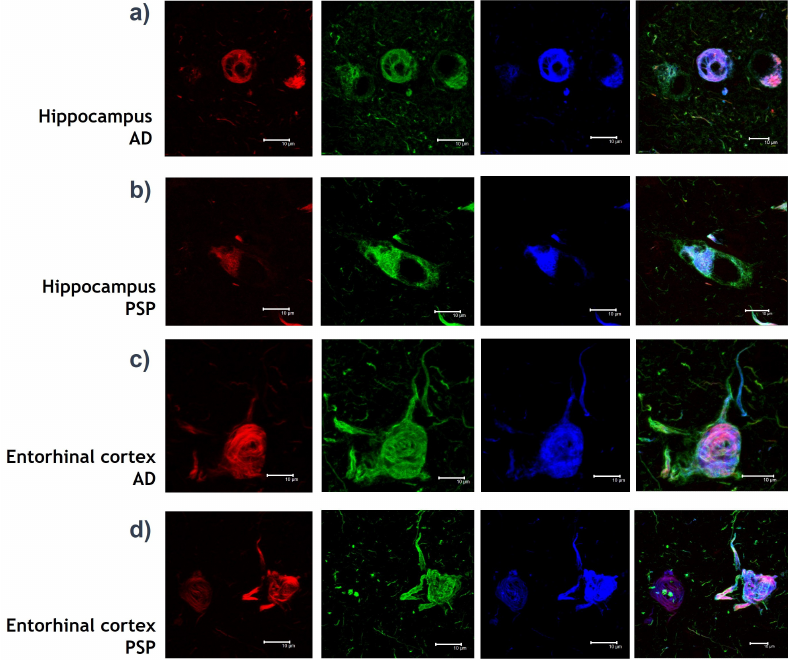
Figure 1. Representative images organized by class and by dataset. ( a ) Images from D1 and D3 corresponding to Alzheimer’s disease (AD). ( b ) Images from D1 and D3 corresponding to Progressive Supranuclear Palsy (PSP). ( c ) Images from D2 and D3 corresponding to AD. ( d ) Images from D2 and D3 corresponding to PSP. From left to right, we can see the IPMB images with the respective green, blue, red and merge channels for different Tau polypeptide biomarkers in both